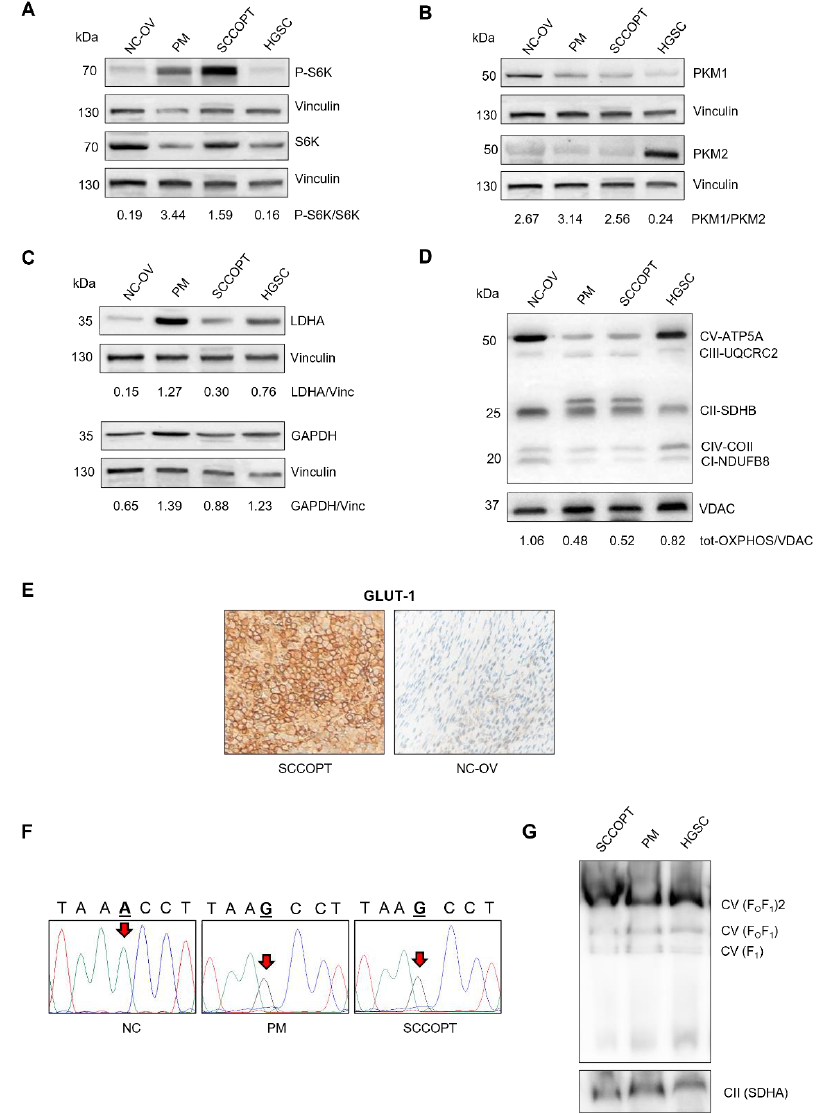
Figure 3. ( A ) Representative western blot analysis of total S6K (S6K) and phosphorylated S6K (P- S6K) in total lysates from non-cancer ovarian tissue (NC-OV), peritoneal metastasis (PM), SCCOPT and ovarian high-grade serous carcinoma (HGSC). Vinculin (Vinc) was used as a loading control. Densitometry values are shown as P-S6K/S6K ratio. ( B , C ) Representative western blot analysis of PKM1 and PKM2 ( B ) and LDHA and GAPDH ( C ) expression levels in total lysates from NC-OV, PM, SCCOPT and HGSC tissues. Vinculin was used as a loading control. Densitometry values are shown as the following ratios: PKM1/PKM2 ( B ), LDHA/Vinc and GAPDH/Vinc ( C ). ( D ) Representative western blot analysis of OXPHOS enzymes (CV-ATP5A, CIII-UQCR2, CII-SDHB, CIV-COII, CI- NDUFB8) in crude mitochondria obtained from NC-OV, PM, SCCOPT and HGSC tissues. VDAC was used as loading control. Densitometry values are shown as tot-OXPHOS/VDAC (tot-OXPHOS: the sum of densitometry values for each lane). ( E ) Immunohistochemical staining of GLUT-1 in SCCOPT and in the residual ovarian parenchyma (NC-OV). Magnification: 400 × . ( F ) Sequence analysis of mtDNA variants in non-cancer (NC), SCCOPT and PM tissues. Red arrows indicate the mutated bases. ( G ) Representative western blot analysis of F o F 1 ATPase (CV) species in crude mitochondria isolated from SCCOPT, PM and HGSC tissues. The assay was performed using a BN-PAGE/Western blot assay, as reported in Materials and Methods. SDHA (CII) was used as a loading